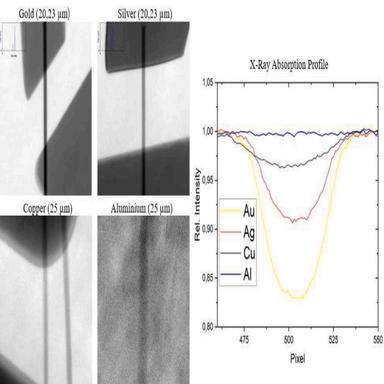
Left: 2-D X-ray images of Au, Ag, Cu and Al of bonding wires with known thickness used in integrated circuits. Right: Corresponding absorption profiles.